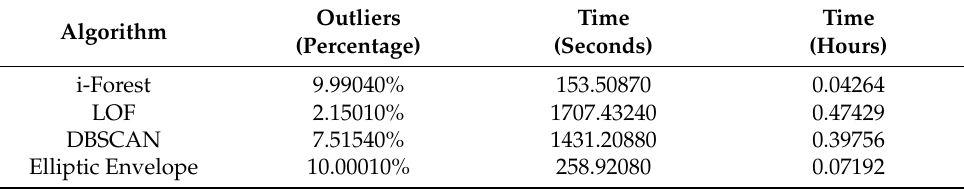
Table 6. Results of multivariate outlier detection analysis using machine learning